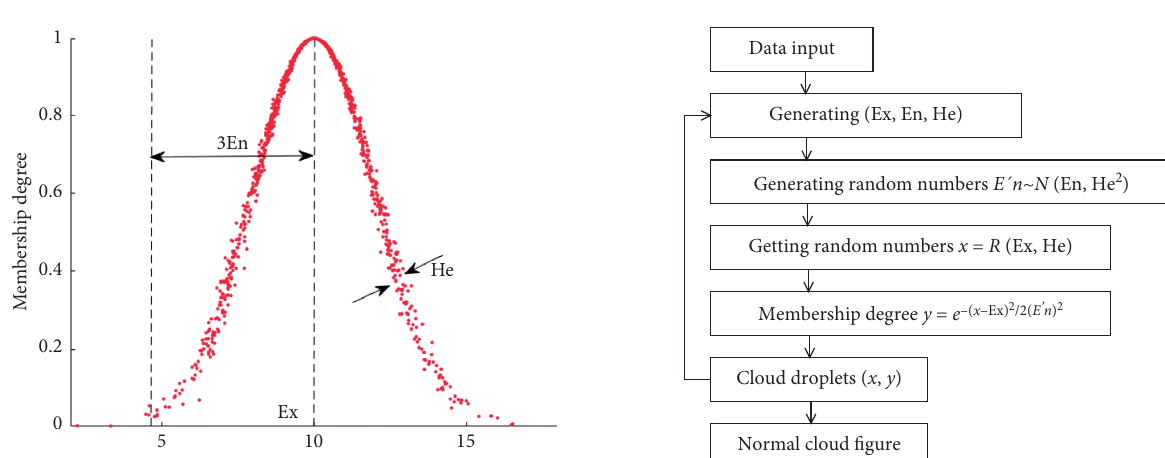
Figure 1: Normal cloud figure. Ex � 10, En � 2, He � 0.1, and n � 1000.